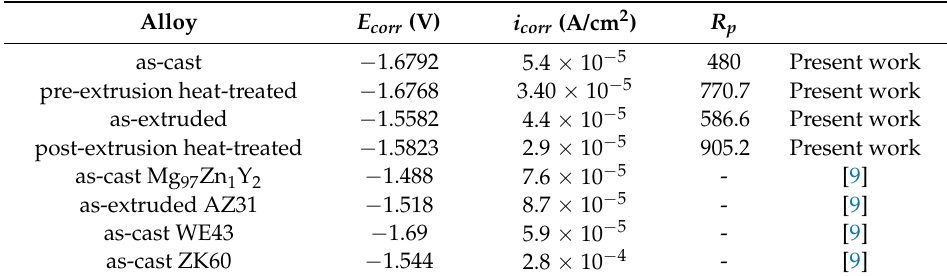
Figure 5. Potentiodynamic polarization curves ( a ) Nyquist plots ( b ) of Mg 95.33 Zn 2 Y 2.67 alloy under different processes in 3.5 wt % NaCl solution; Equivalent circuit model ( c ) for the as-extruded and ( d ) for the rest three alloys. Table 1. Parameters of potentiodynamic polarization curves fitted by R p mode and the typical alloys previously